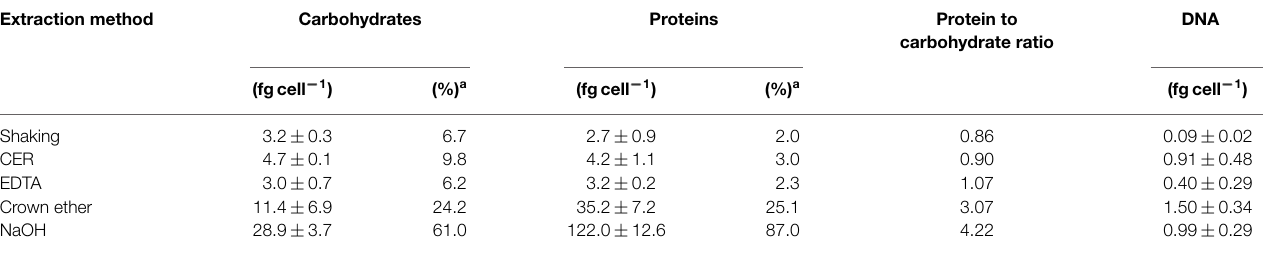
TABLE 2 | Carbohydrate, protein, and DNA content of EPS extracted from S. acidocaldarius biofilms with shaking, CER, EDTA, crown ether, and NaOH . Extraction method Carbohydrates Proteins Protein to